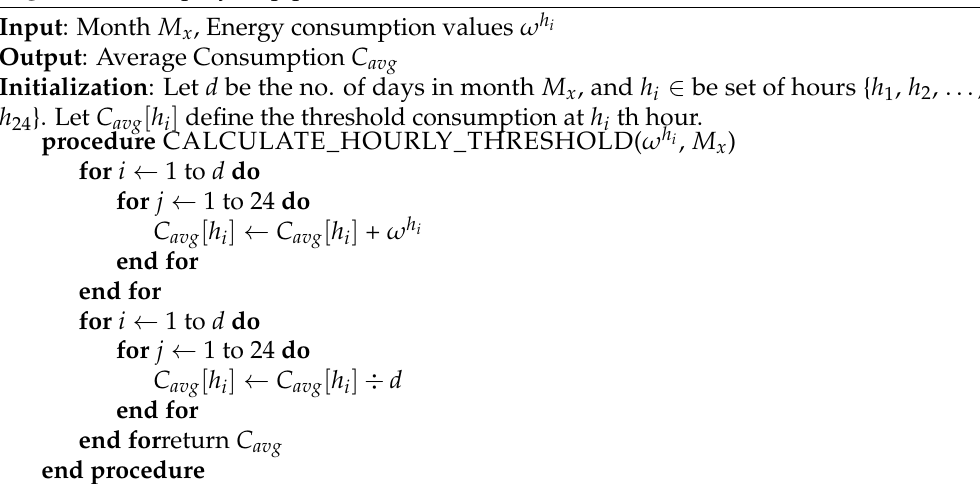
Algorithm 1 Step-by-step process to calculate the threshold